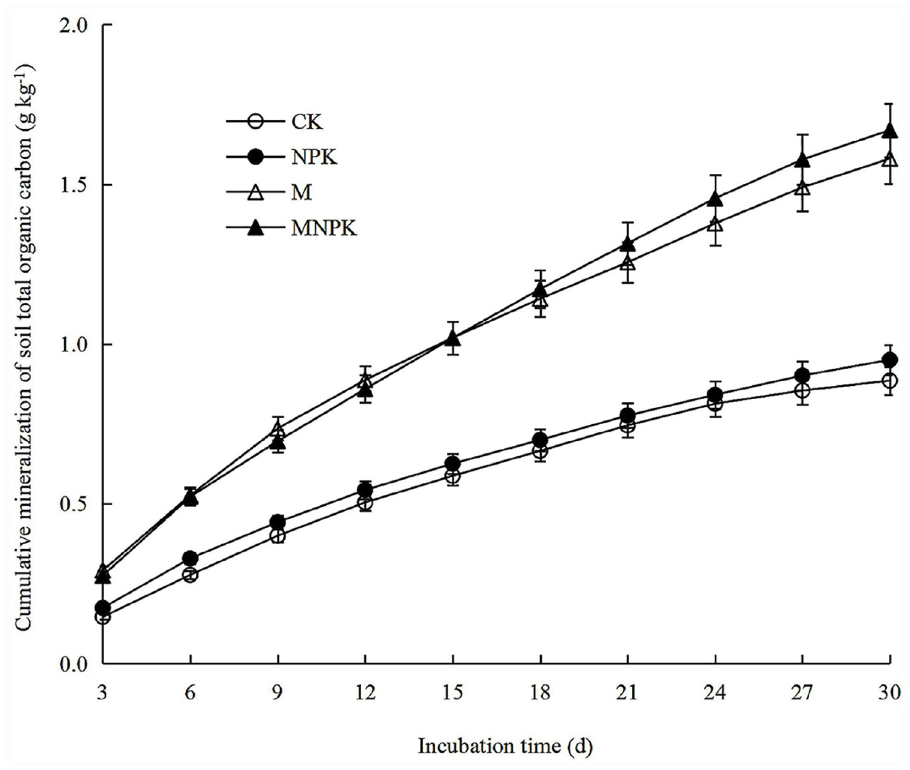
Fig 1. Cumulative carbon mineralization during 30 days of incubation. Data points represent averages ± standard errors (n = 3).